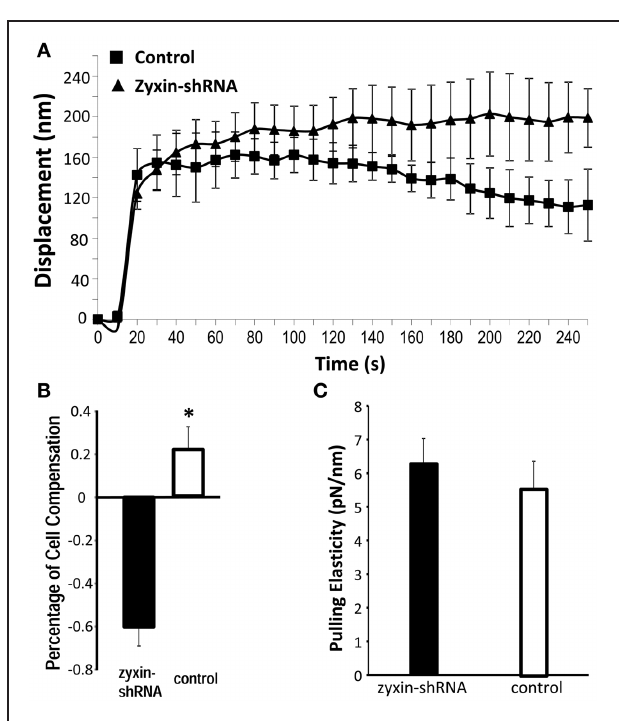
FIGURE 4 | Zyxin silencing reduced pulling force response in VSMC. The AFM probe with FN-coated beads were placed into contact with the cell surface of VSMC (zyxin-shRNA or control). AFM pulling forces were then applied to the bead from the cell surface in z-axis. The displacement (nm) of the bead over 250s was shown to indicate the VSMC response to the pulling force. ( n = 5, p < 0 . 004 vs. control). (B) Percentage of cell compensation as an indicator of quantified cellular micro-myogenic response. (C) Comparison of the apparent pulling elasticity indicating no significant change in the FN-focal adhesion strength. Error bars represent standard error of the mean. * p < 0 .